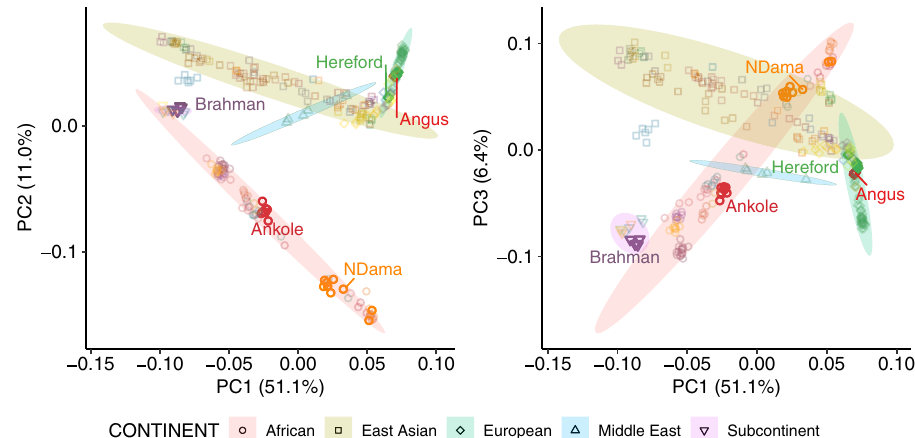
Fig. 1 Principal component analysis of the 294 cattle. The positions of the populations of origin of the fi ve assemblies considered in this study are shown. The source data are provided with the paper.